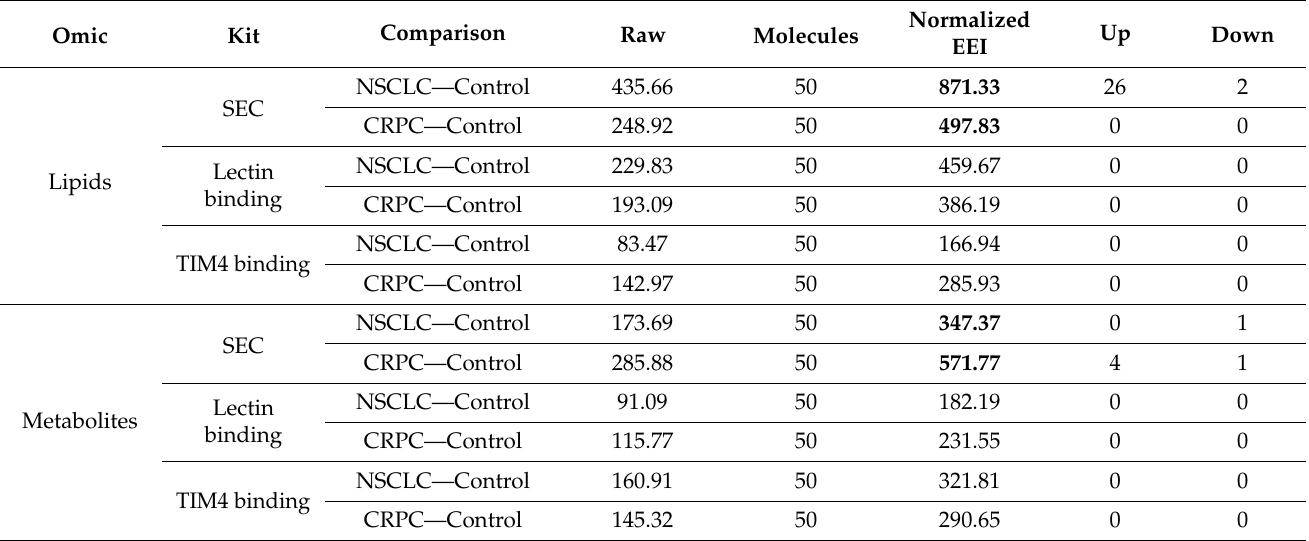
Table 4. Exosome enrichment index (EEI) indicating that SEC identified the most significant molecules between patients and